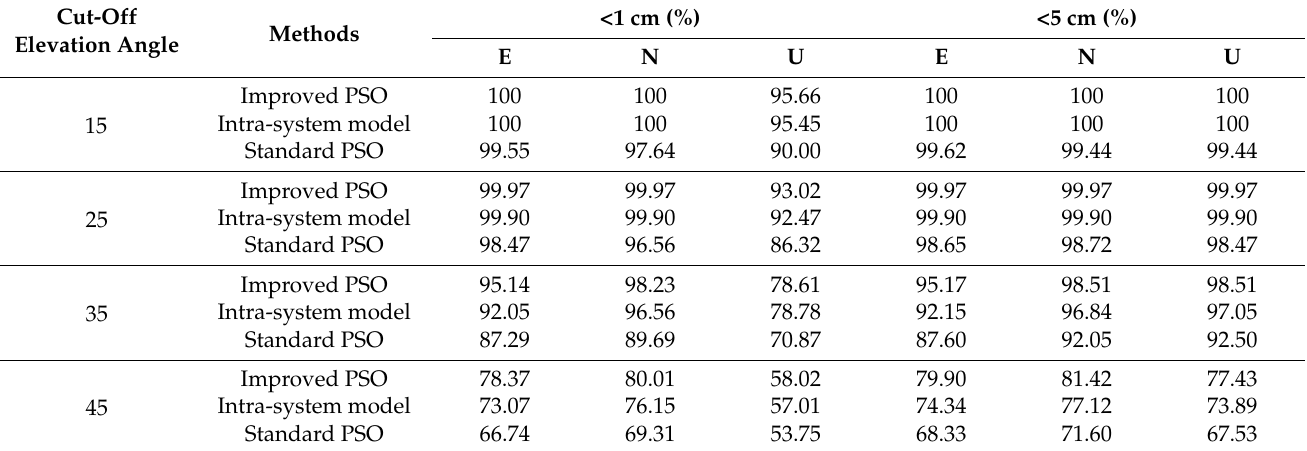
Table 2. Percentage of epochs with positioning errors less than 1 cm and 5 cm at different cut-off elevation angles. Cut-Off Elevation Angle